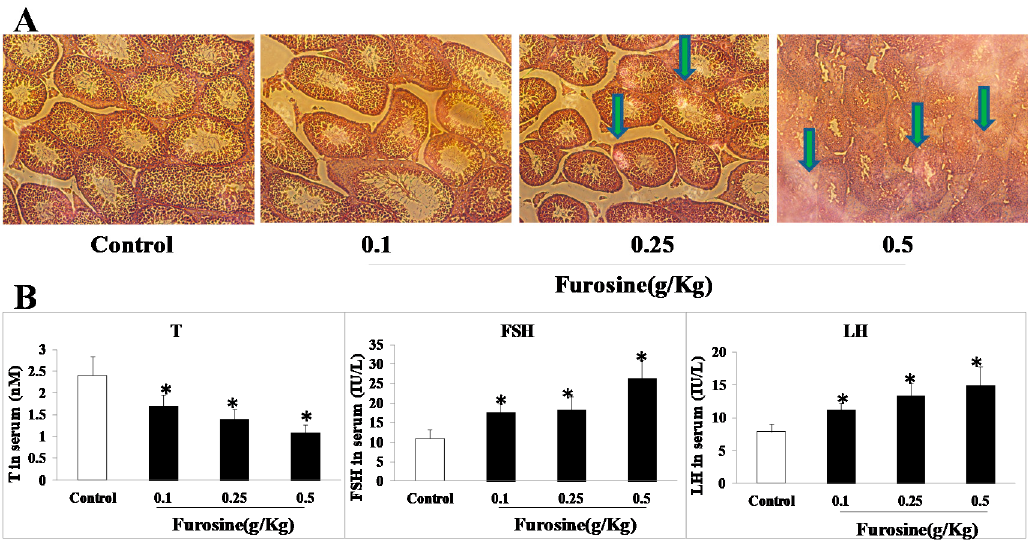
Figure 2. Furosine affected pathological conditions of testicle tissue and hormones in serum. ( A ) Pathological conditions of testicle tissue (×200). The green arrows stood for the apparent pathological changes of testicle tissue. ( B ) The levels of testosterone (T), follicle stimulating hormone (FSH), and luteinizing hormone (LH) in mice serum. All the data were represented as mean ± SD, n = 8. * Comparing with the control, p ﹤ 0.05.